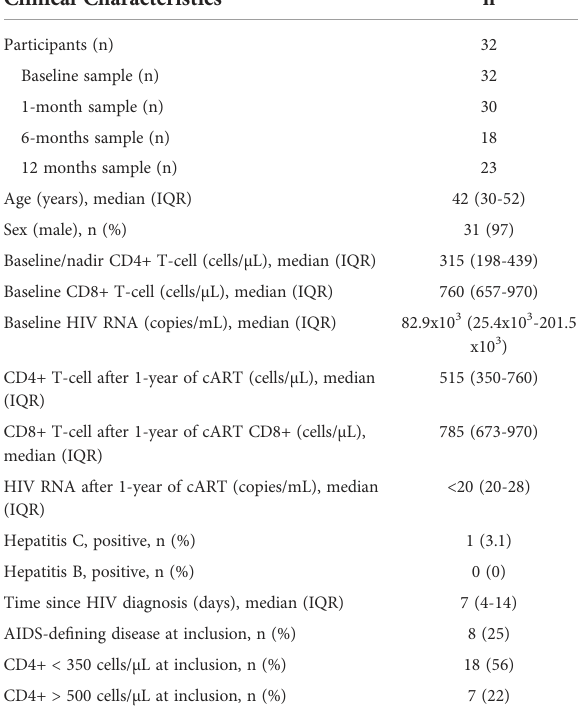
TABLE 1 Clinical characteristics. Clinical